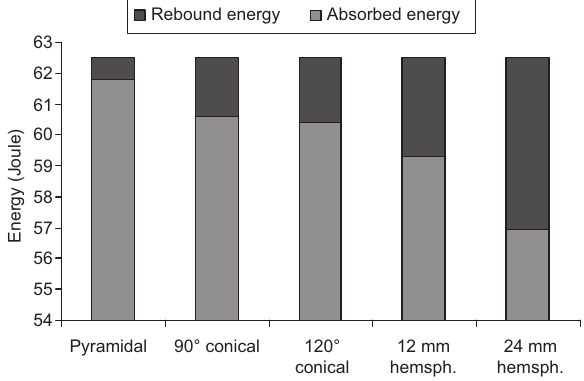
Figure 11 The overall damage area values for various taps.